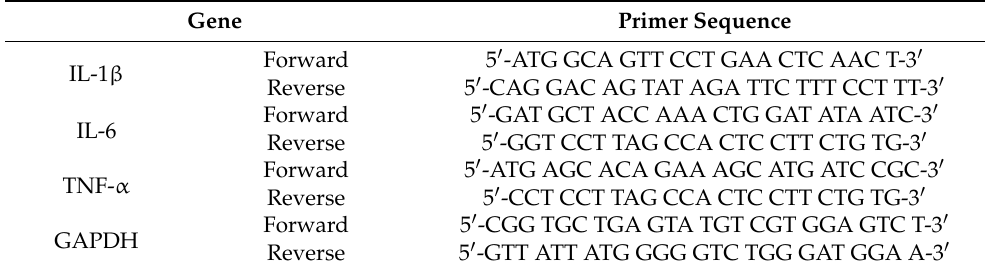
Table 1. Real-time PCR primer